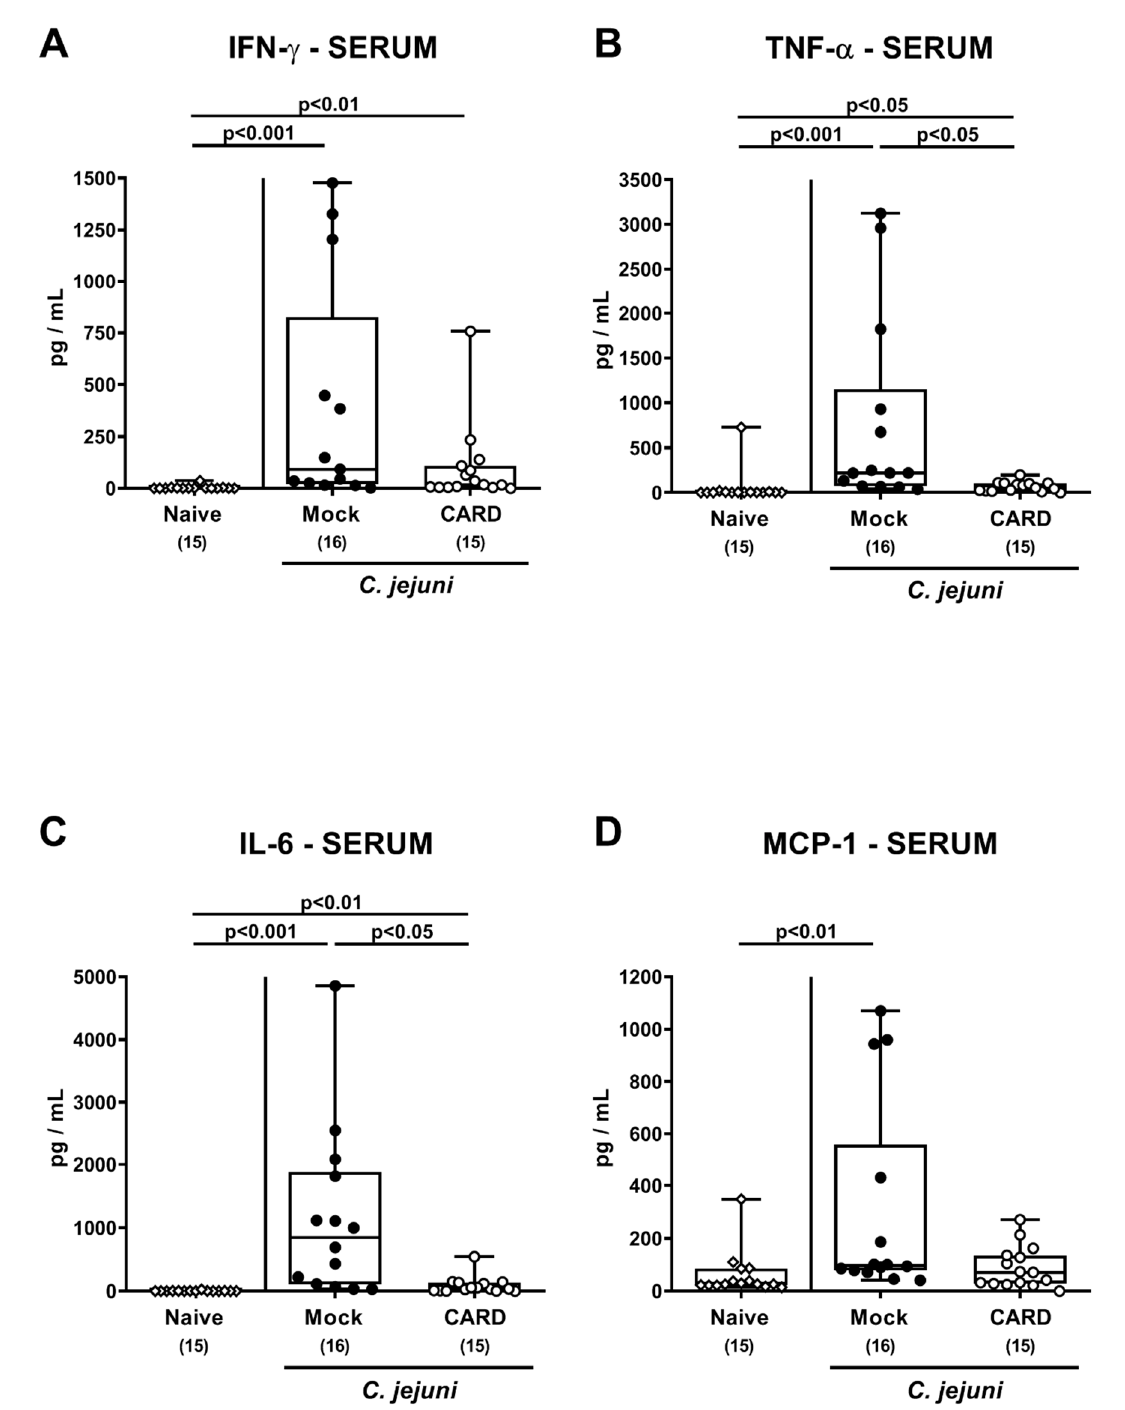
Figure 8. Systemic pro-inflammatory mediator secretion following oral cardamom essential oil application to C. jejuni - infected microbiota-depleted IL-10 − / − mice. Microbiota-depleted IL-10 − / − mice were infected with C. jejuni strain 81–176 on days 0 and 1 by gavage and perorally challenged with cardamom essential oil (CARD; white circles) via the drinking water starting on day 2 post-infection, whereas mock control mice received vehicle (black circles). On day 6 post-infection, ( A ) IFN- γ , ( B ) TNF- α , ( C ) IL-6, and ( D ) MCP-1 concentrations were measured in serum samples. Naive mice (open diamonds) served as untreated and uninfected controls. The box plots indicating the 75th and the 25th percentiles of the median (black bar within box), the total range, the levels of significance ( p values) as calculated with the Kruskal–Wallis test and Dunn’s post-correction, and the number of analyzed mice (in parentheses) are shown. Data were pooled from four independent experiments.